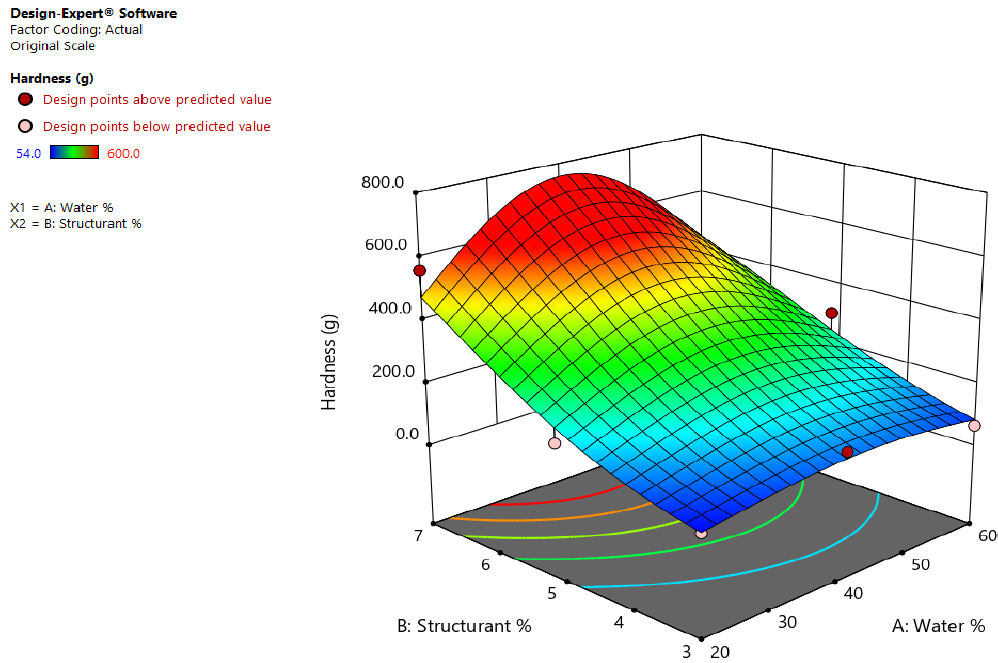
Figure 1. Effects of wax and water concentration on the hardness of shellac wax oleogel emulsions.